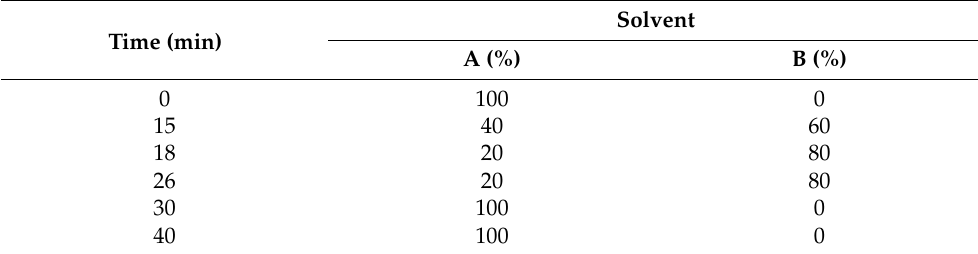
Table 1. Solvent gradient program for the analysis of Dynantin entrapment, plasma stability and in vivo distribution using 25% acetonitrile in water (A) and acetonitrile (B), both with 0.1% trifluo- roacetic acid ( v/v